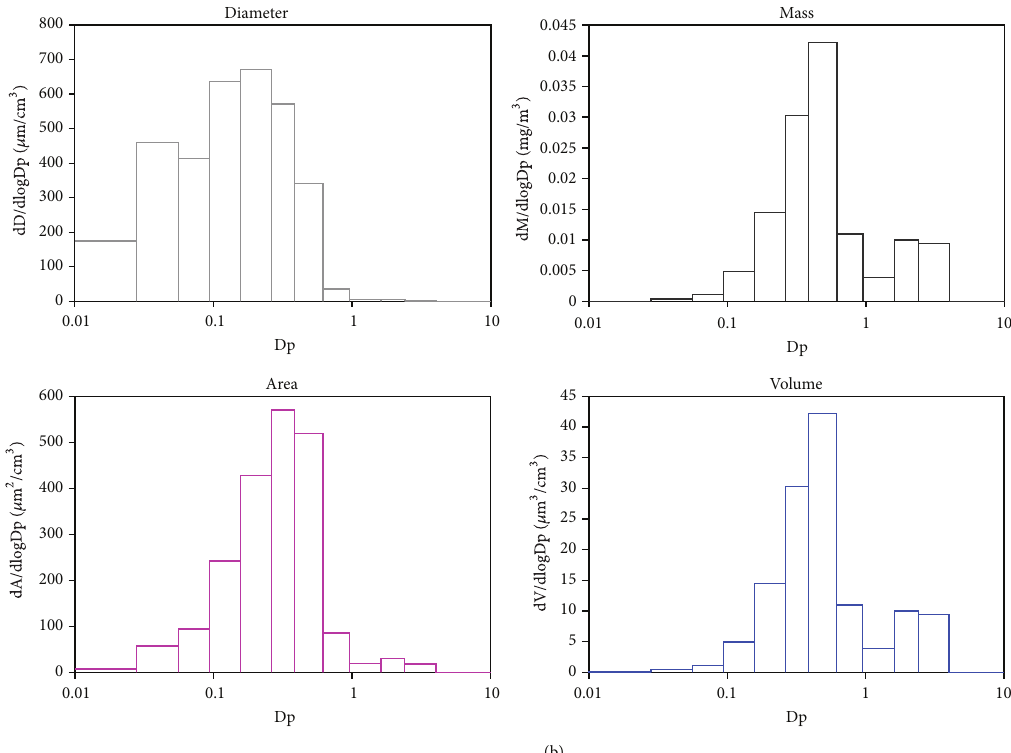
F 2: Histograms of particle distribution obtained during one measurement day for on (a) and b40 (b) fuels. Legend: Dp-Particle aerodynamic diameter,